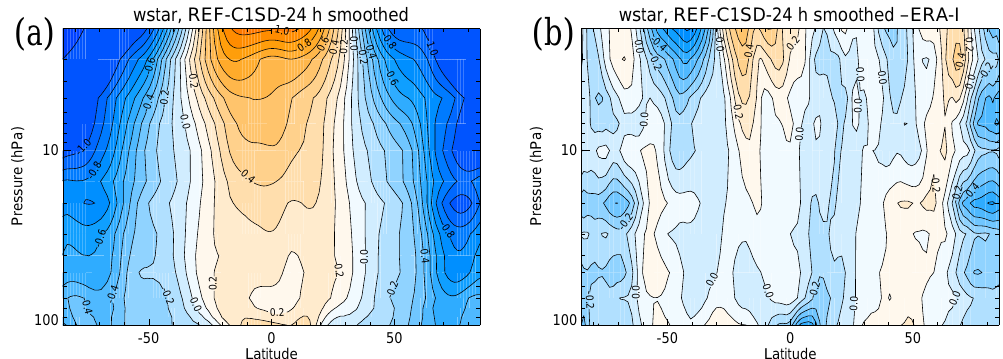
Figure 9. Zonal-mean annual mean climatologies in residual vertical velocity for (a) REF-C1SD (nudged simulation) and (b) differences between the REF-C1SD simulation and ERA-Interim. The years 1989–2009 are used. Unlike temperature and zonal wind, the biases in residual vertical velocity are not negligible for the nudged simulations (see text for details).